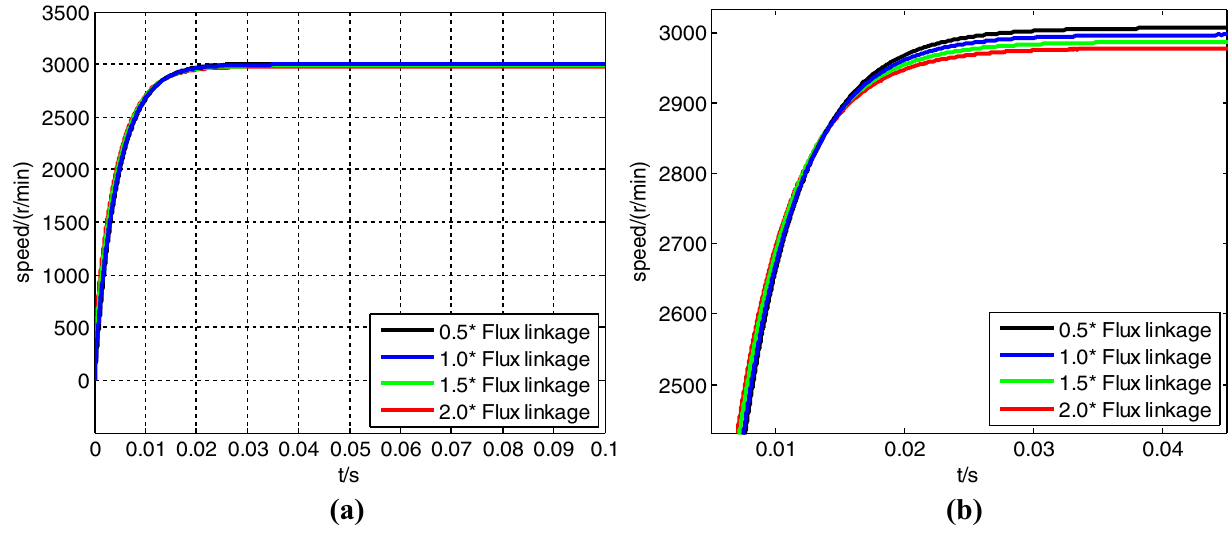
Fig. 14 The comparison of speed tracking with varying flux linkage: a speed response curve of 0–0.1 s, b transient speed response curve of 0–0.05